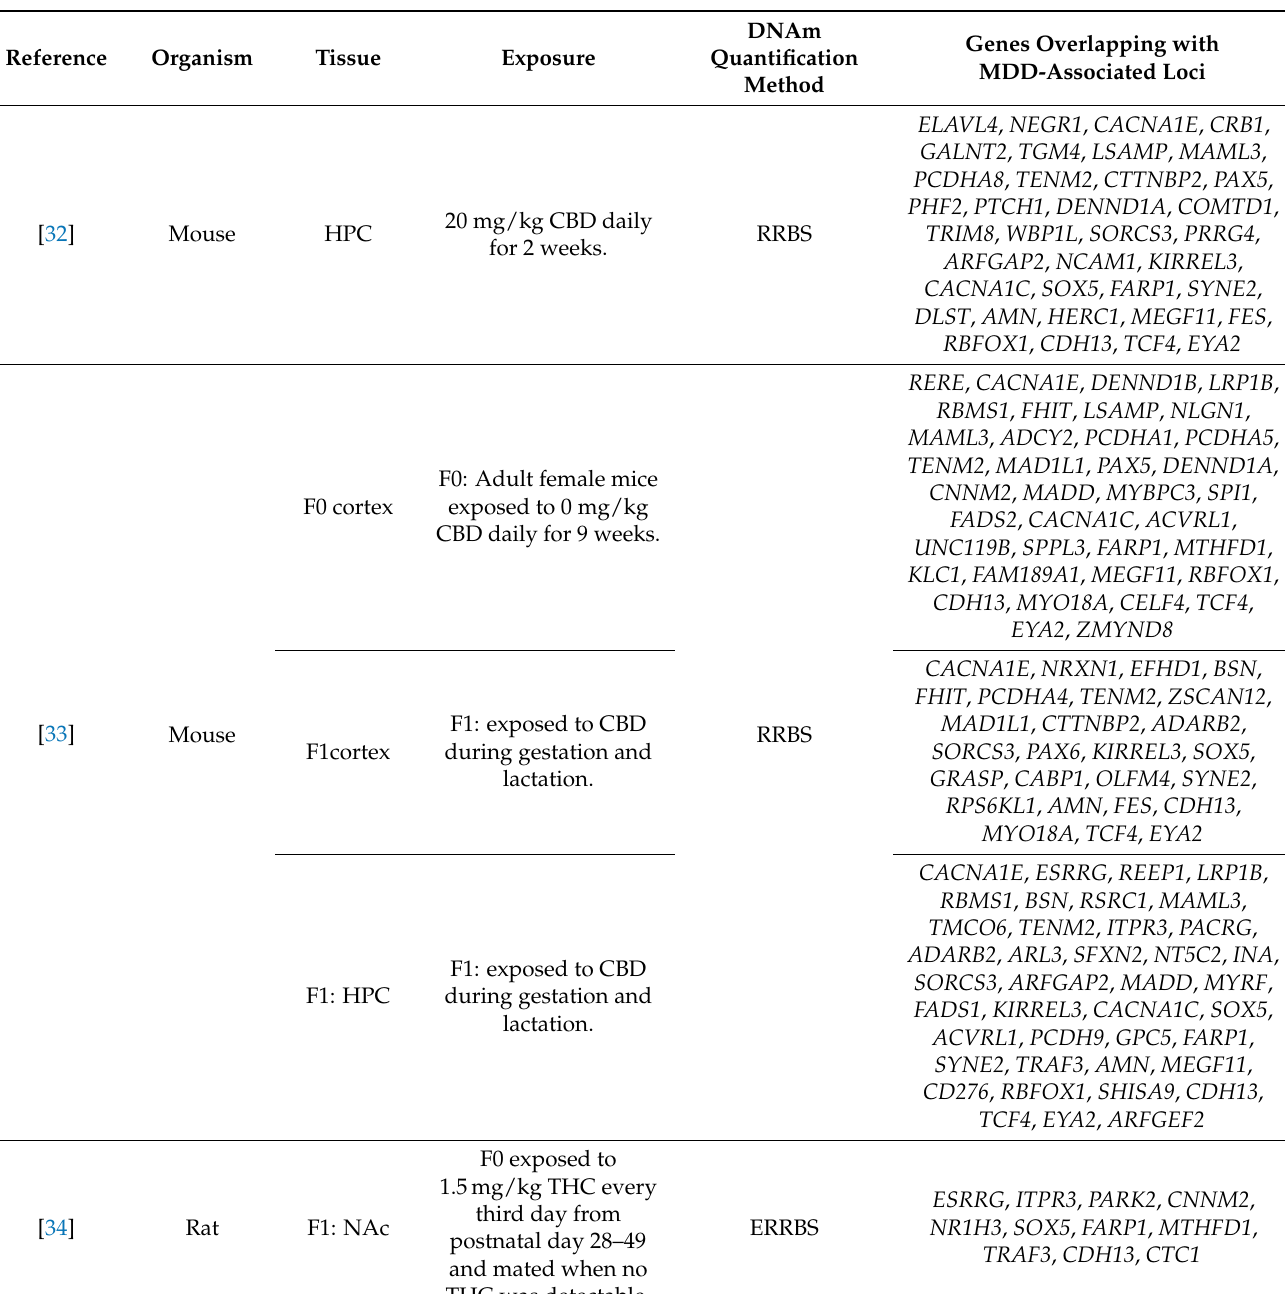
Table 1. Overview of genes residing in GWAS MDD-associated loci [18] and genes differentially methylated upon exposure to cannabis or cannabis-derived compounds (CBD or